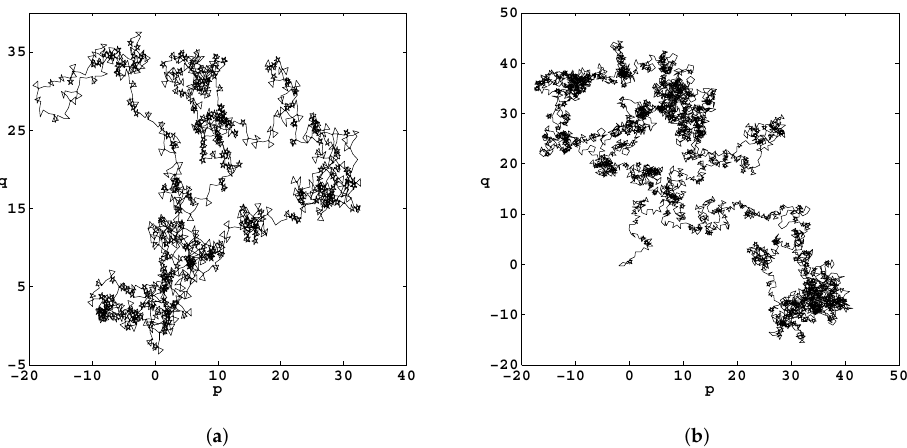
Figure 4. The 0-1 test results. Variables q − p for: ( a ) a sequence of 7th bits of logistic map with µ = 3.50 XORed with chaotic bits of the Chua (Matsumoto) circuit yield K = 0.9974; ( b ) as in part ( a ) but for µ = 3.99, resulting in K =